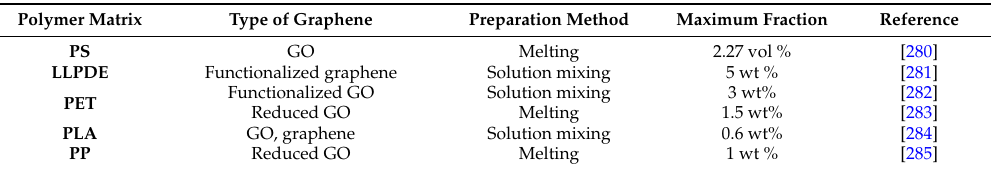
Table 4. Representative examples of graphene-based nanocomposites targeting to improve gas barrier properties